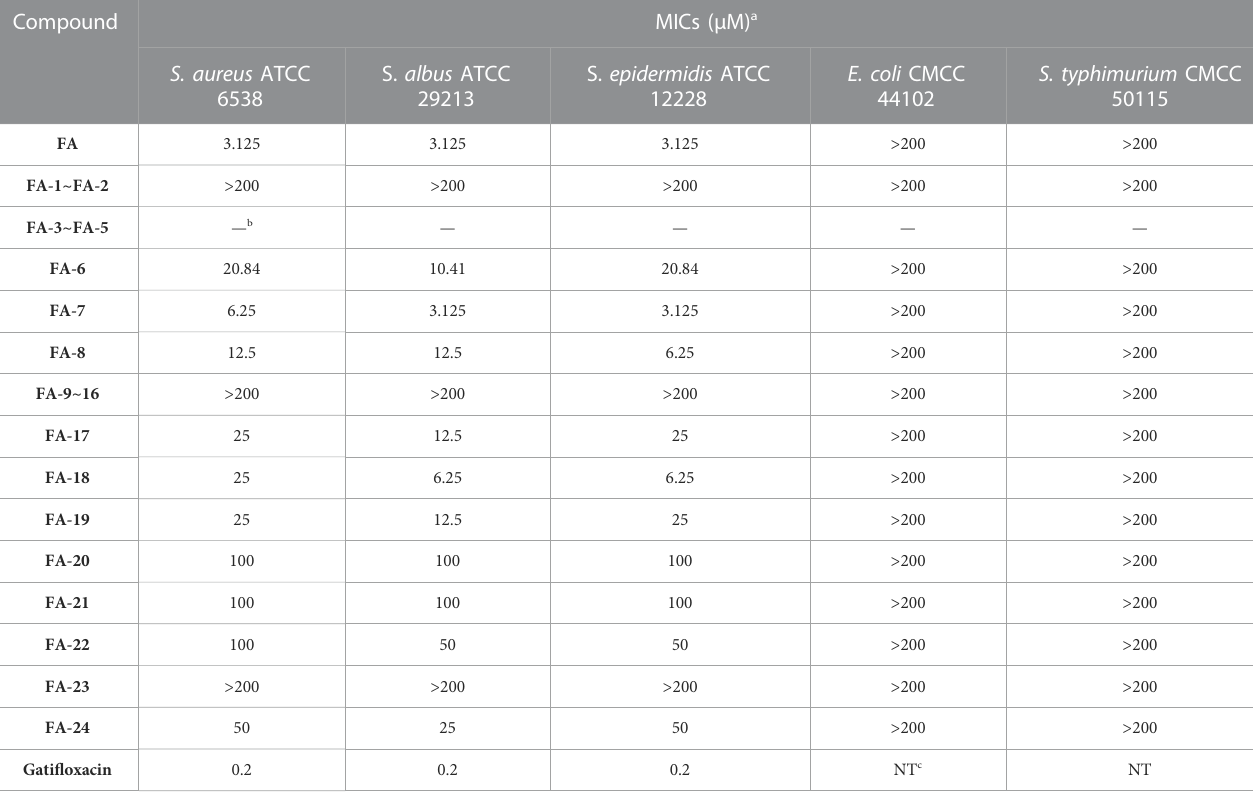
TABLE 4 MICs of FA and its derivatives against the bacterial strains.